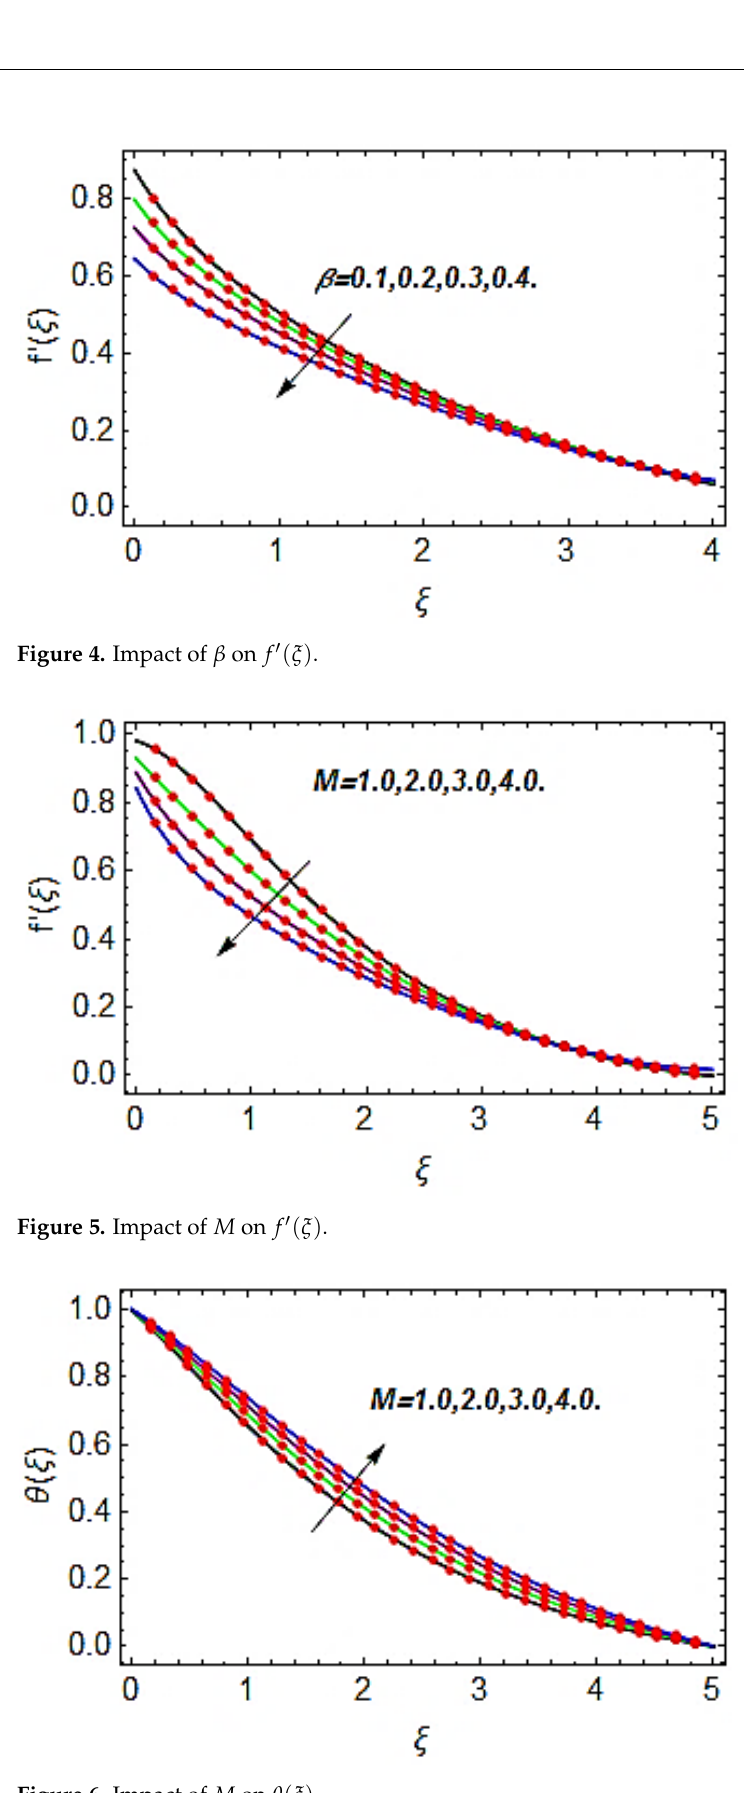
Figure 6. Impact of M on θ ( ξ )